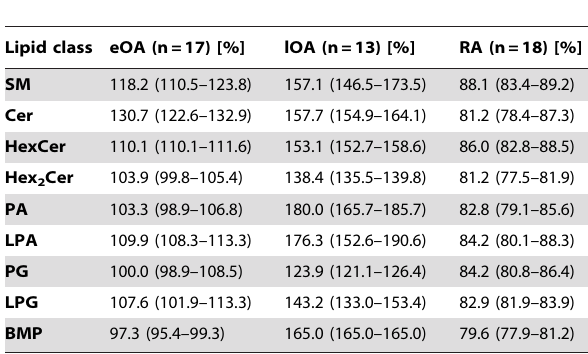
Table 3. Impact of dilution factor on the concentrations of lipid